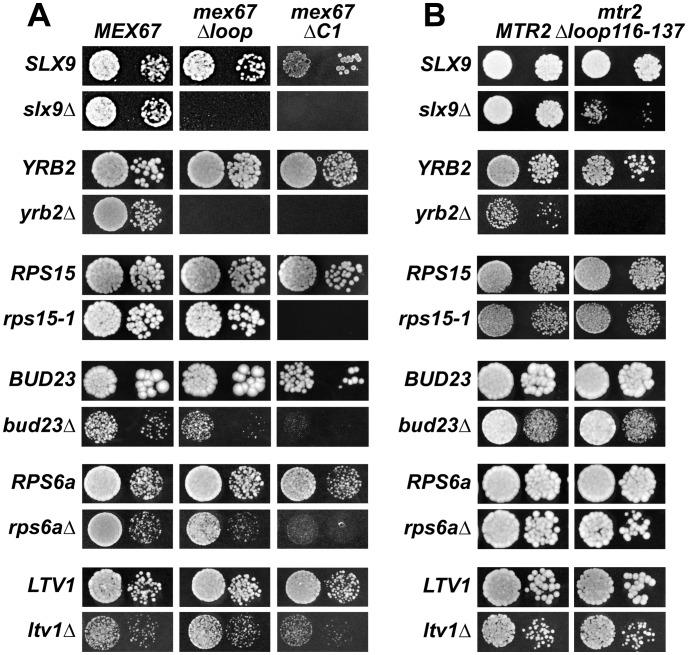
Mex67 and Mtr2 genetically interact with factors required for proper pre40S subunit export.(A and B) mex67Δloop, mex67ΔC1 and mtr2Δloop116-137 alleles are synthetic lethality (sl) or synthetic enhancement (se) when combined with the indicated slx9Δ, yrb2Δ, rps15-1, bud23Δ, rps6aΔ and ltv1Δ mutants. Strains carrying the WT and mutant alleles were spotted in 10-fold serial dilutions on 5-FOA (SD) plates (when sl) or YPD plates (when se) and grown at 20–25°C for 3–9 days.